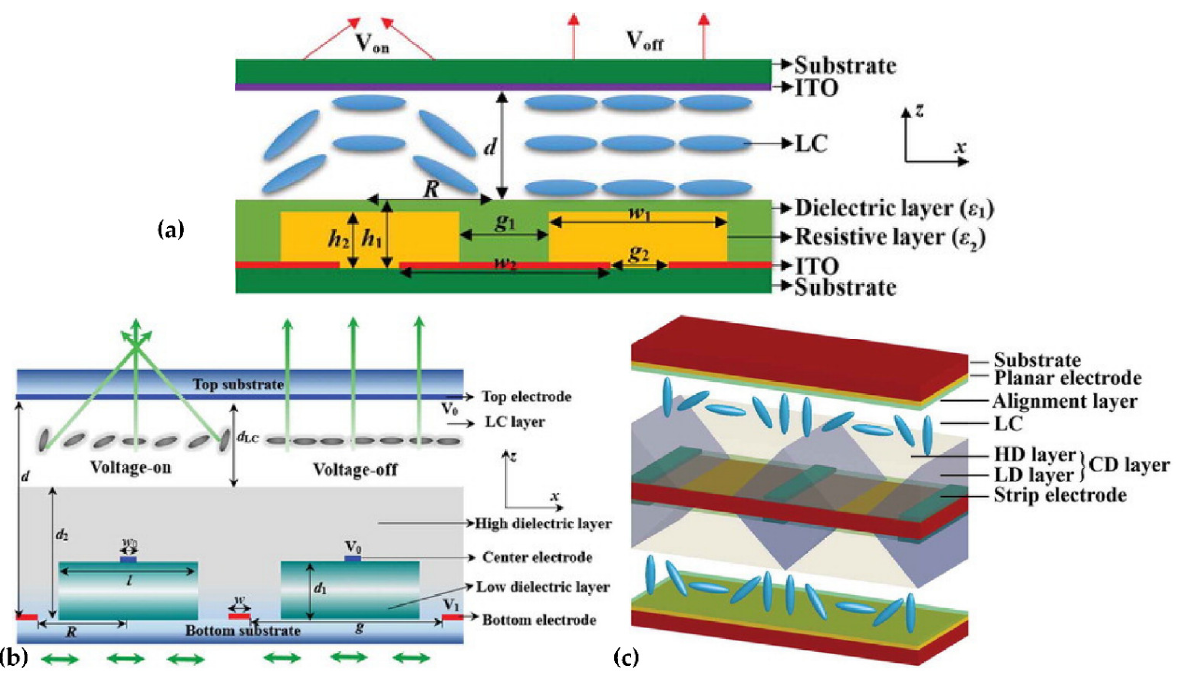
Figure 6. LC lens arrays with different layers: ( a ) resistive layer [27], ( b ) low dielectric layer [50] and ( c ) composited dielectric layer [51]. Reprinted with permission from Ref. [27,50,51]. 2020 Taylor & Francis.